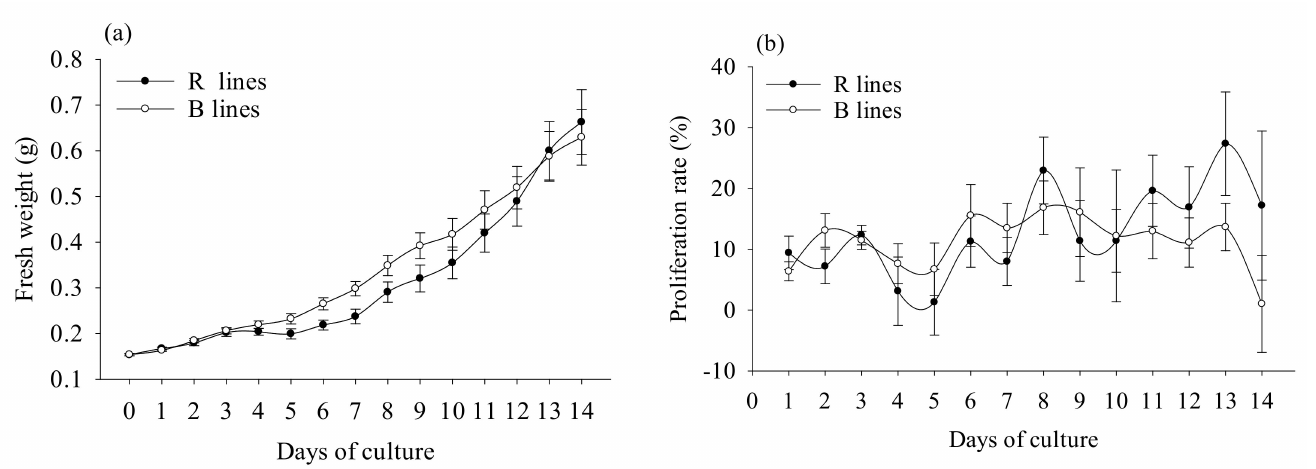
Figure 3. Changes in P. koraiensis R and B cell lines during proliferation. ( a ) Fresh weight (FW) changes in R and B cell lines during proliferation. ( b ) Changes in proliferation rate in R and B cell lines during